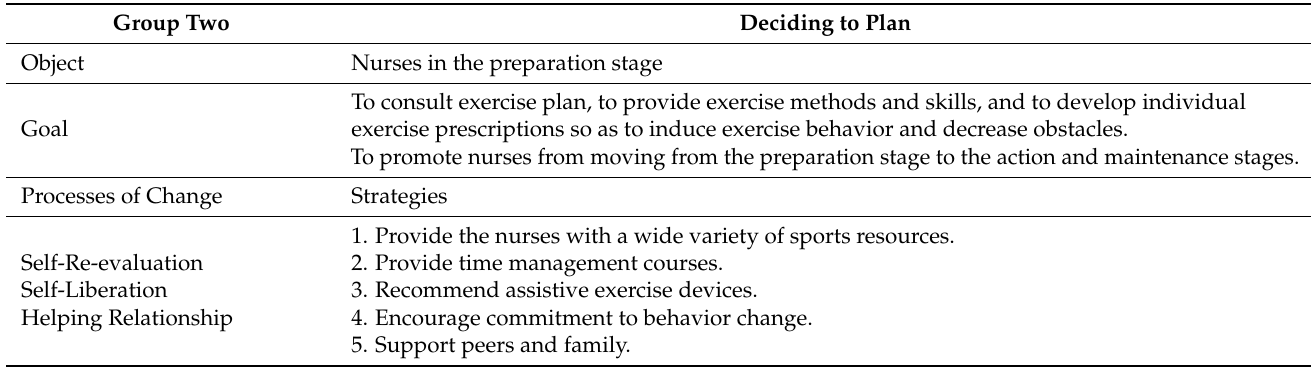
Table 2. Teaching strategies for group two—“Deciding to Plan”.